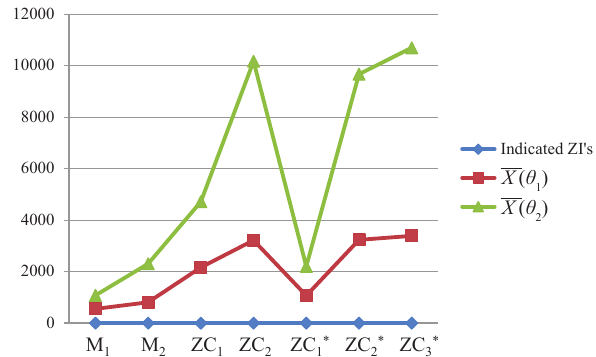
Figure 11: Graph for arithmetic mean (A.M) of the indicated ZI’s for both operations based on Table